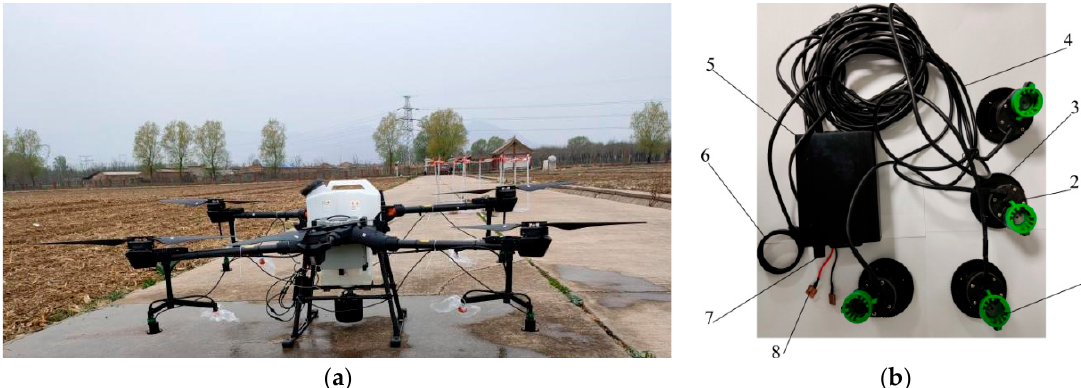
Figure 3. DJI T20 UAVS and electronically controlled RA system. (1) Nozzle body, (2) brushless motor, (3) fluted disc, (4) power line, (5) control box, (6) induction ring, (7) ESC and (8) electrodes. ( a ) DJI T20 UAVS carrying RA and ( b ) electronically controlled RA